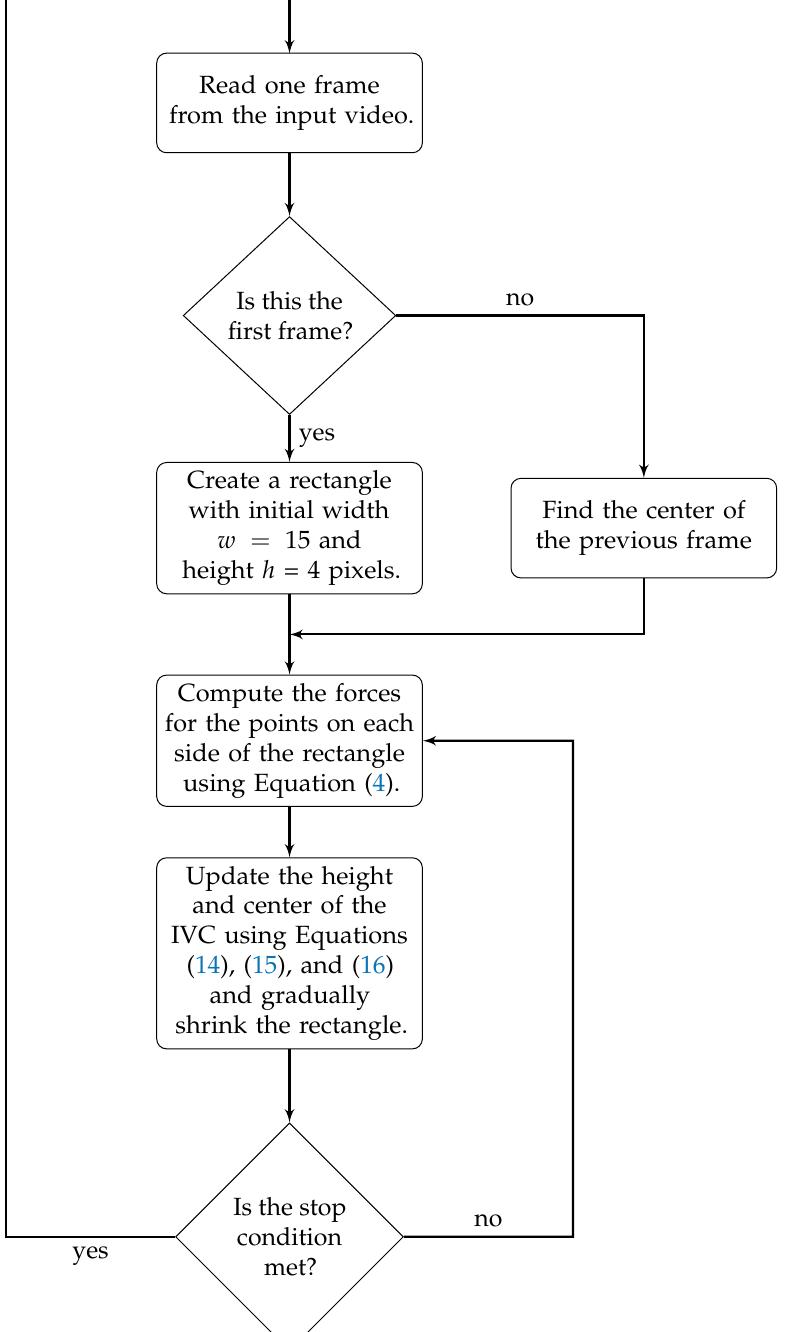
Figure 3. Flowchart for the proposed active rectangle algorithm for estimation and tracking of the IVC AP-diameter from ultrasound